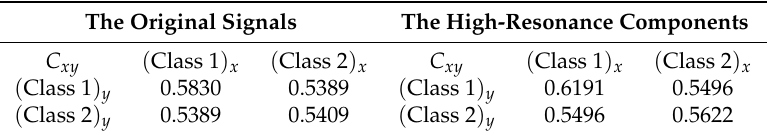
Table 2. The Results of Calculating C xy